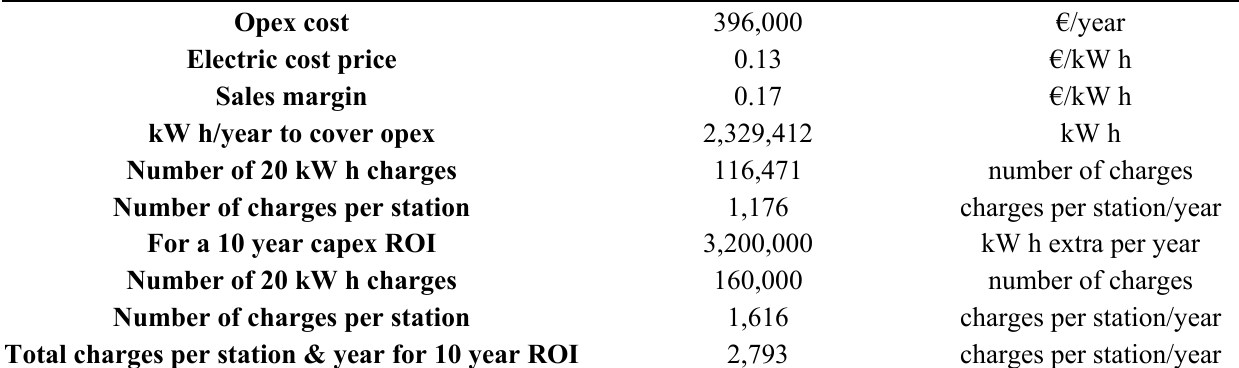
Table 7. Cost-benefit